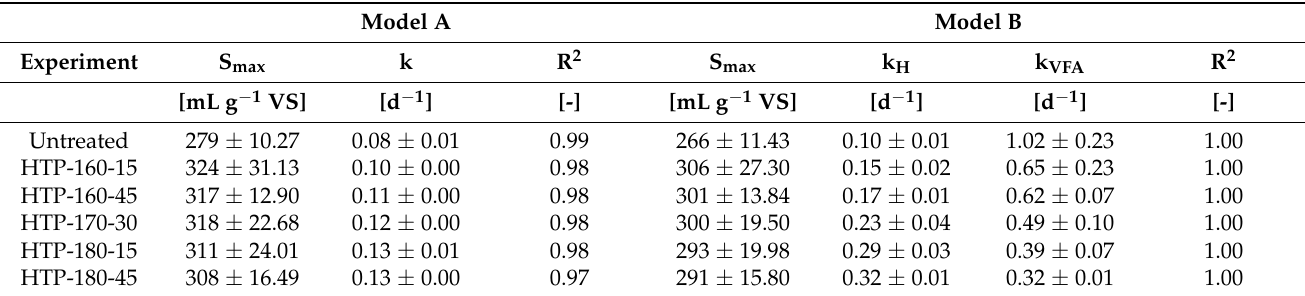
Table 7. Results of kinetic parameter